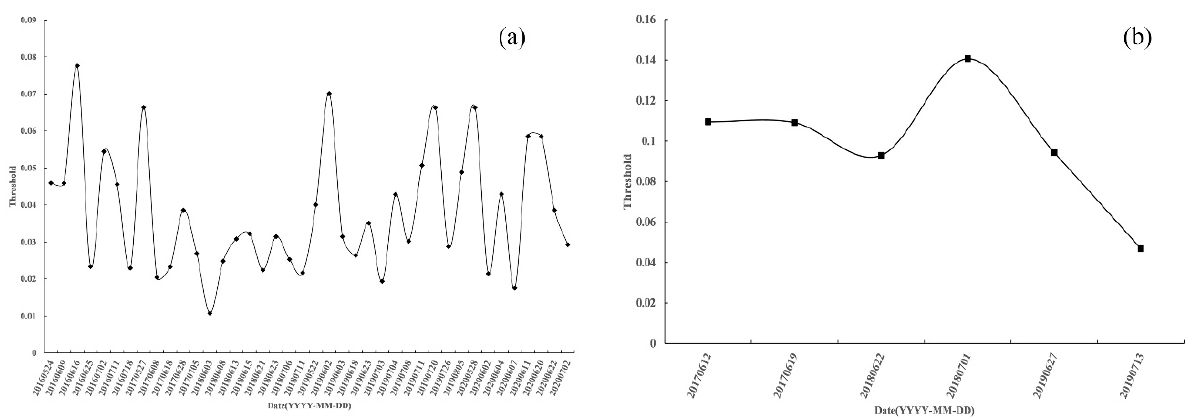
Figure 15. Statistical of optimal threshold of U. prolifera in the study area from 2016 to 2020: ( a ) threshold by FAI-COM; ( b ) threshold by NDVI-COM.